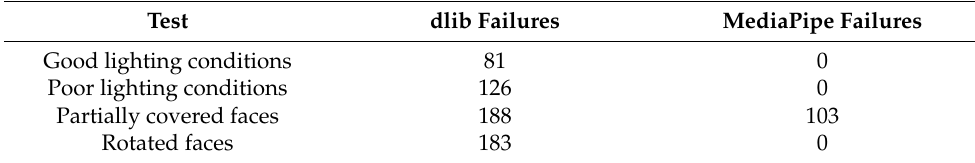
Table 7. Built-in for dlib and